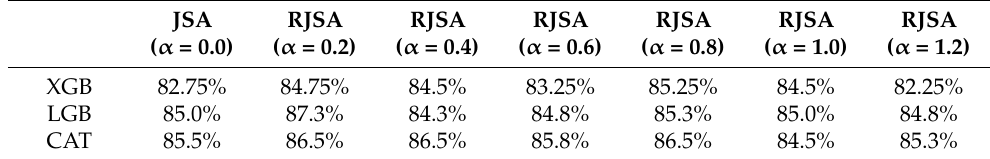
Table 5. The sound classification algorithms based on XGB/LGB/CAT and RJSA